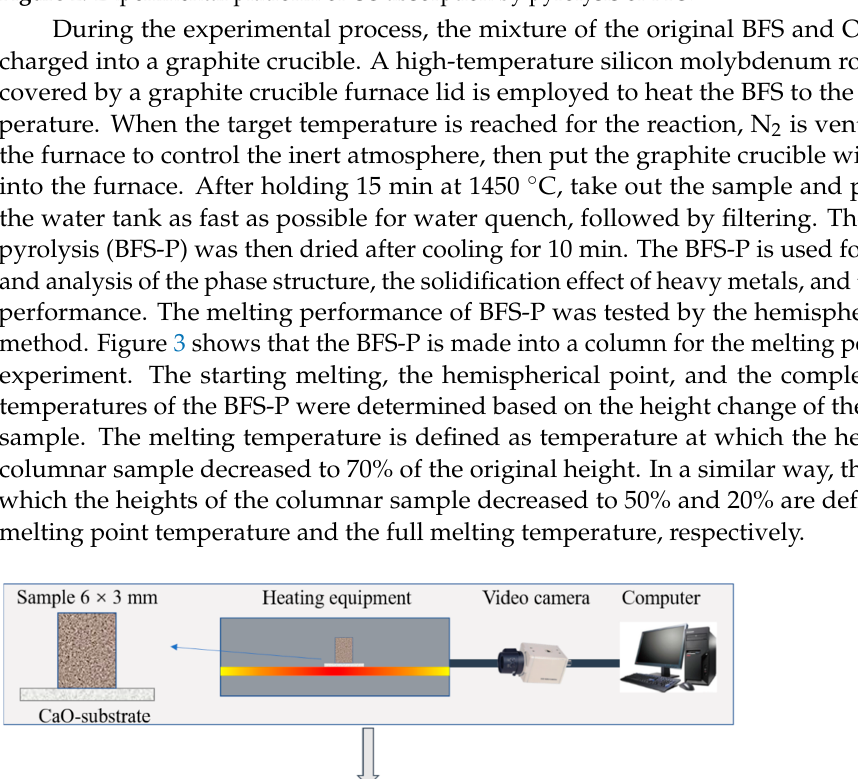
Figure 4. Original BFS and the slag after pyrolysis (BFS-P). As can be seen in Figure 5, The main ore phases of the BFS-P significantly changed compared with the original BFS. The original BFS mainly consists of a glass phase with an amorphous peak and substantially small tricalcium aluminate (Ca 3 Al 2 O 6 ), while the peak was more obviously in the BFS-P. The main diffraction peak of the BFS is wollastonite (Ca 2 SiO 4 ) and Ca 3 Al 2 O 6 . The Ca 3 Al 2 O 6 diffraction peak in the BFS-P showed a rising trend with an increasing OS mass. The Ca 2 SiO 4 phase appeared when 10% OS was added into BFS. However, it disappeared with an OS amount higher than 30%, and only Ca 3 Al 2 O 6 was detected. Ca 3 Si 2 O 7 appeared in the BFS-P as the amount of OS had a continuous in- crease. The main crystalline phase of the BFS-P is Ca 3 Al 2 O 6 , when the heat incorporation of the OS is 50%. The results show that the pyrolysis residue of the oil-bearing sludge reconstructed the mineral phase of the original BFS. However, the phase of the BFS-P is consistent with the requirement for cement production. Therefore, the BFS-P can still be